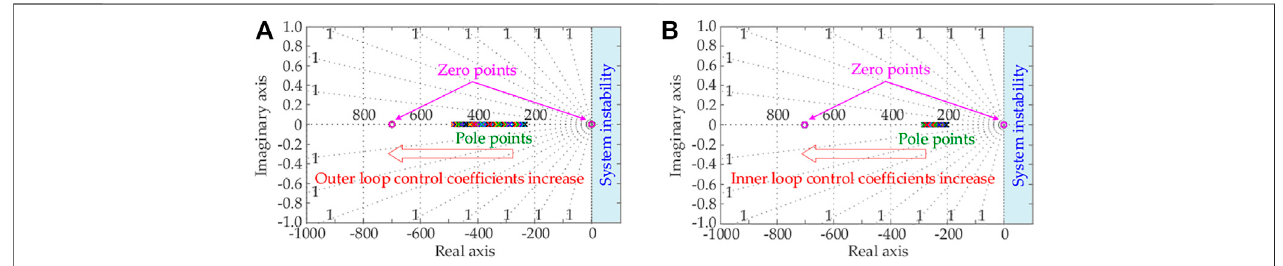
FIGURE7| Zero-poledistributionmapof T ( s ) : (A) zero-poledistribution mapofouterloopcontrolcoef fi cientvariation; (B) zero-poledistribution mapofinnerloop control coef fi cient variation.